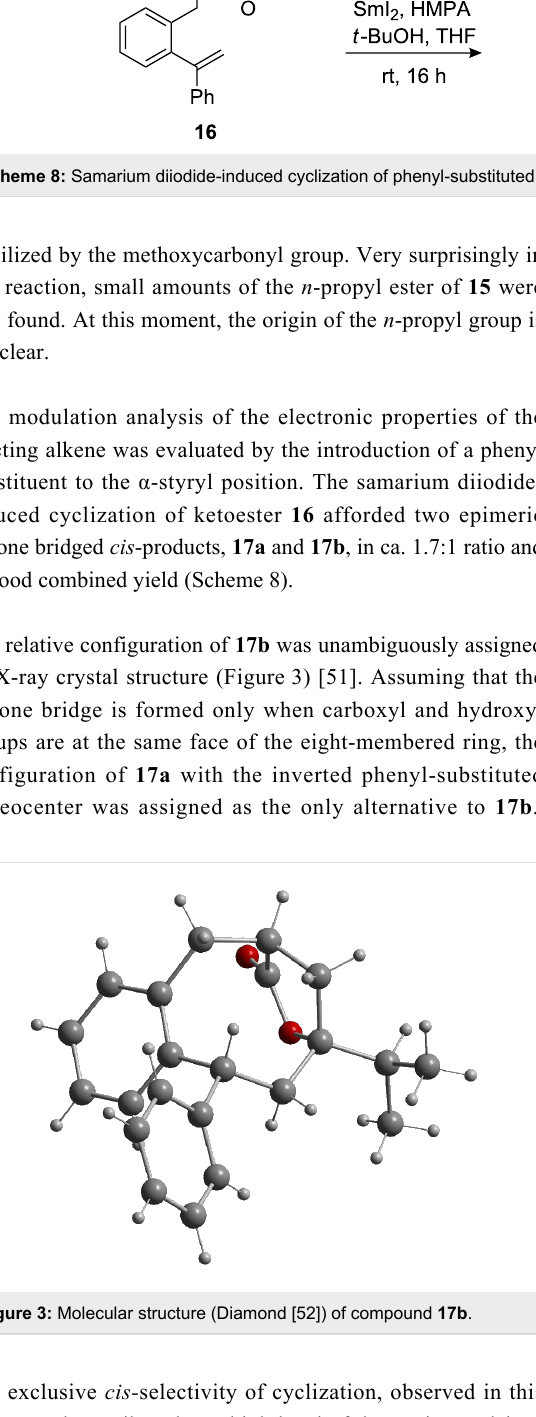
Scheme 8: Samarium diiodide-induced cyclization of phenyl-substituted substrate 16 leading to lactones 17a and 17b .